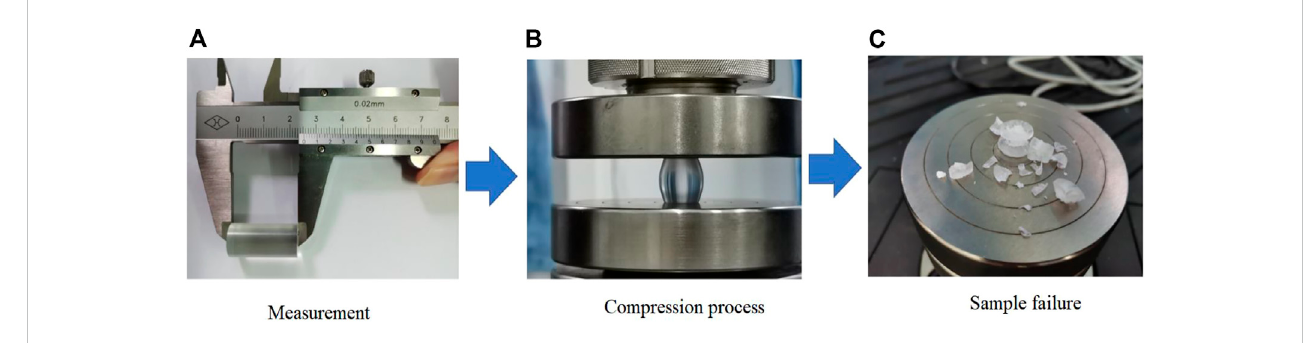
FIGURE 1 Experimental test process.